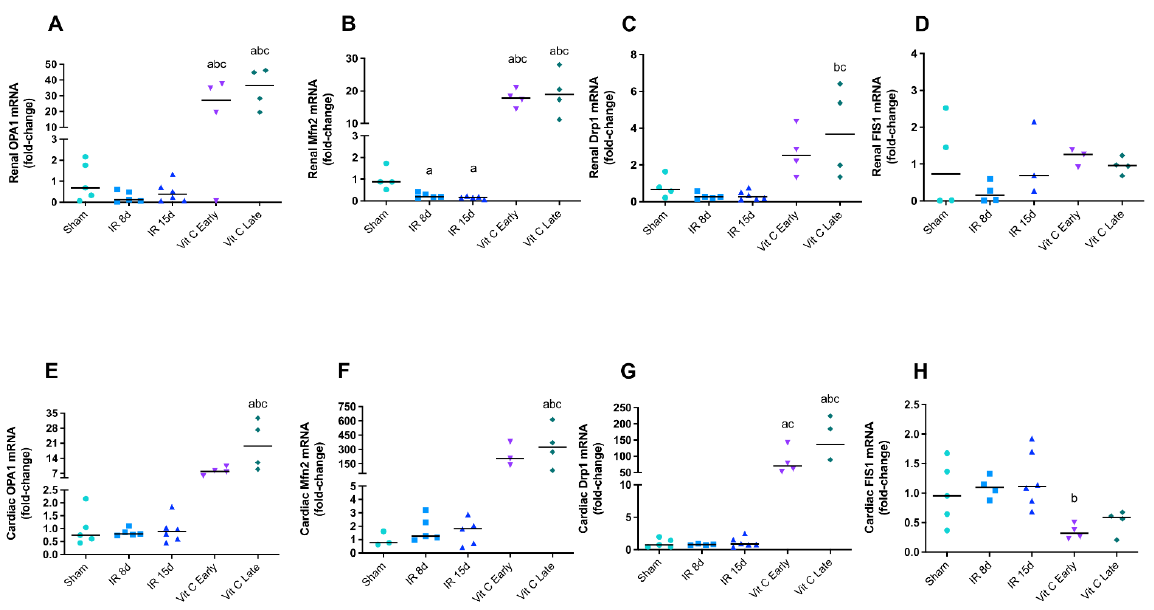
Figure 2. Mitochondrial dynamic components in CRS 3 model after vitamin C treatment. OPA 1 mRNA levels ( A ), Mitofusin 2 mRNA levels ( B ), Drp 1 mRNA levels ( C ), and FIS 1 mRNA levels ( D ) in the left kidney. OPA 1 mRNA levels ( E ), Mitofusin 2 mRNA levels ( F ), Drp 1 mRNA levels ( G ), and FIS 1 mRNA levels ( H ) in the heart. Data are expressed as the mean ± standard error of mean (SEM), and one-way ANOVA followed by the Tukey’s post hoc test were performed. a vs. sham, p < 0.05. b vs. IR8d, p < 0.05. c vs. IR15d, p < 0.05.